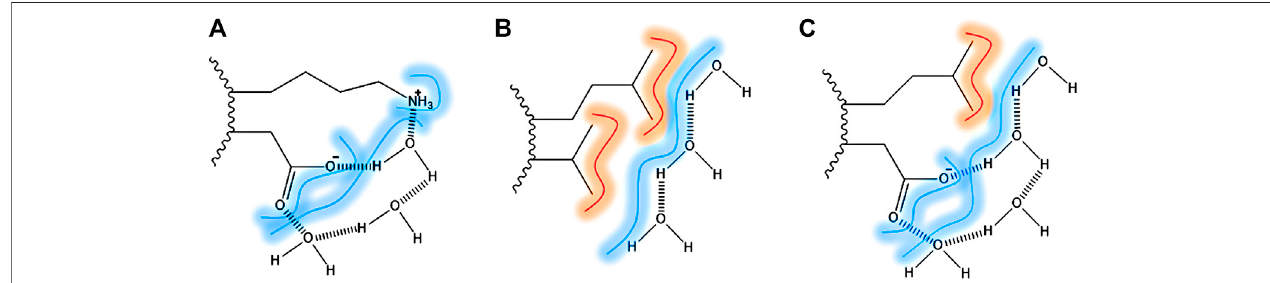
FIGURE 1 | Surface direct forces: amino acid residues exposed to the surface bridged by hydrogen bonds and VDW interaction with water (dash). (A) Lysine and aspartic acid as an example of two polar amino-acid side chains bridged by water molecules; (B) Leucine and alanine side-chains as an example of two apolar amino- acid side chains and the VDW interactions; (C) Leucine and aspartic acid as an example of apolar and polar amino-acid side